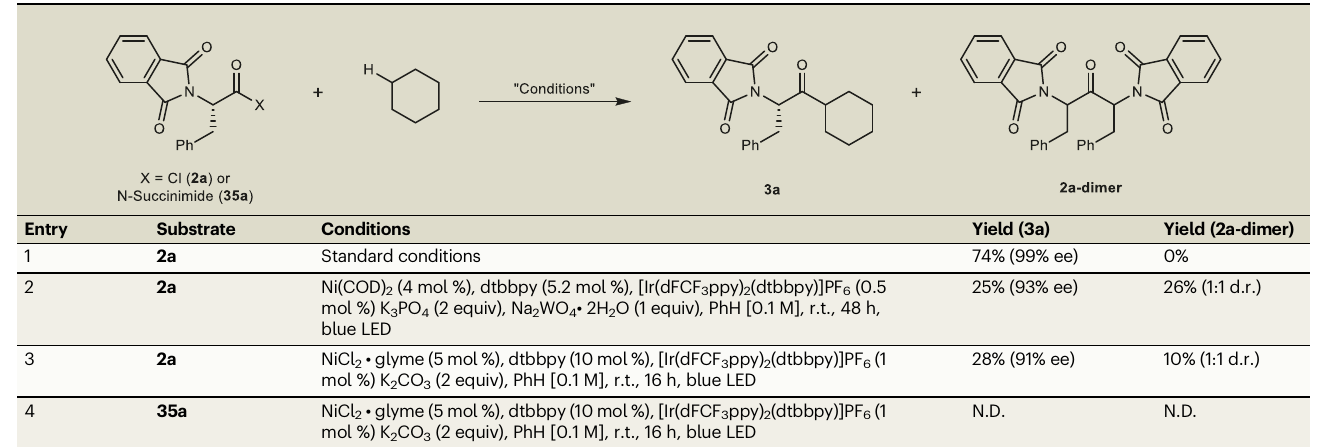
Table 2 | Control experiments under reported conditions for Ni/Ir-catalyzed C(sp 3 ) – H acylation